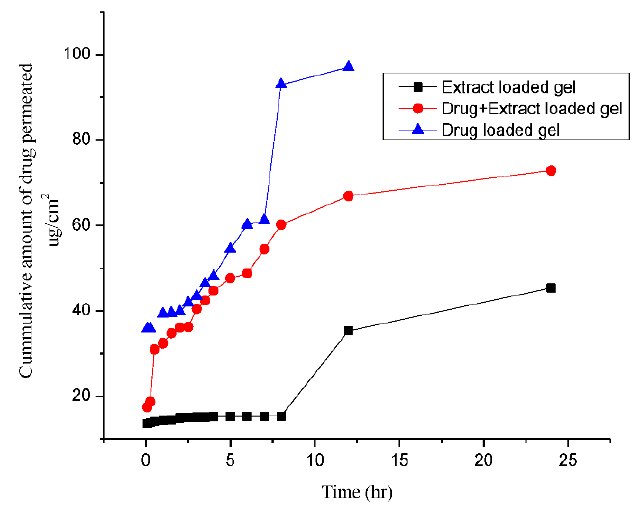
Figure 6. Drug permeability studies from different formulations.